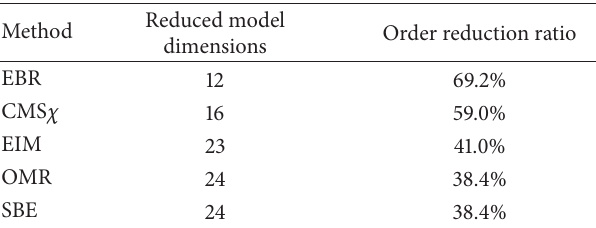
Table 2: Dimensions of the reduced models ensuring MAC ≥ 0.999 and 𝜀 𝑔 ≤ 1% for each